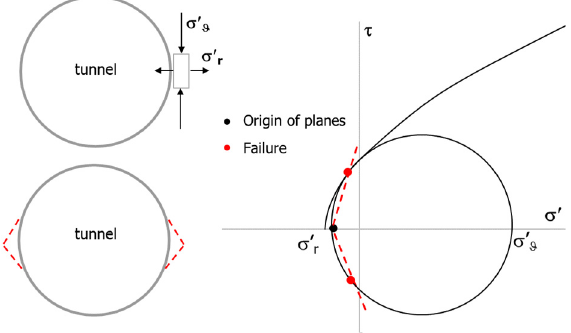
Figure 4. Failure in the tension zone as a function of the induced state of stress. The dotted red lines are the failure planes. Table 2. Stresses used in the analysis of u lim . The factor K = 0.7 in both cases.